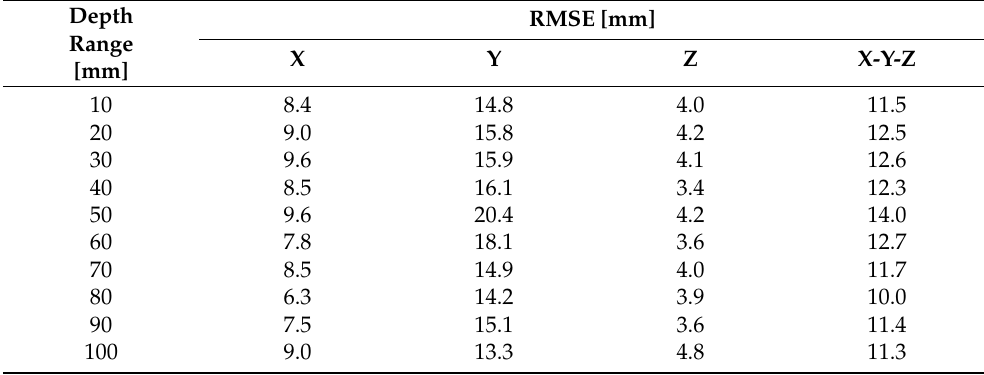
Table 5. RMSE corresponding to the Z